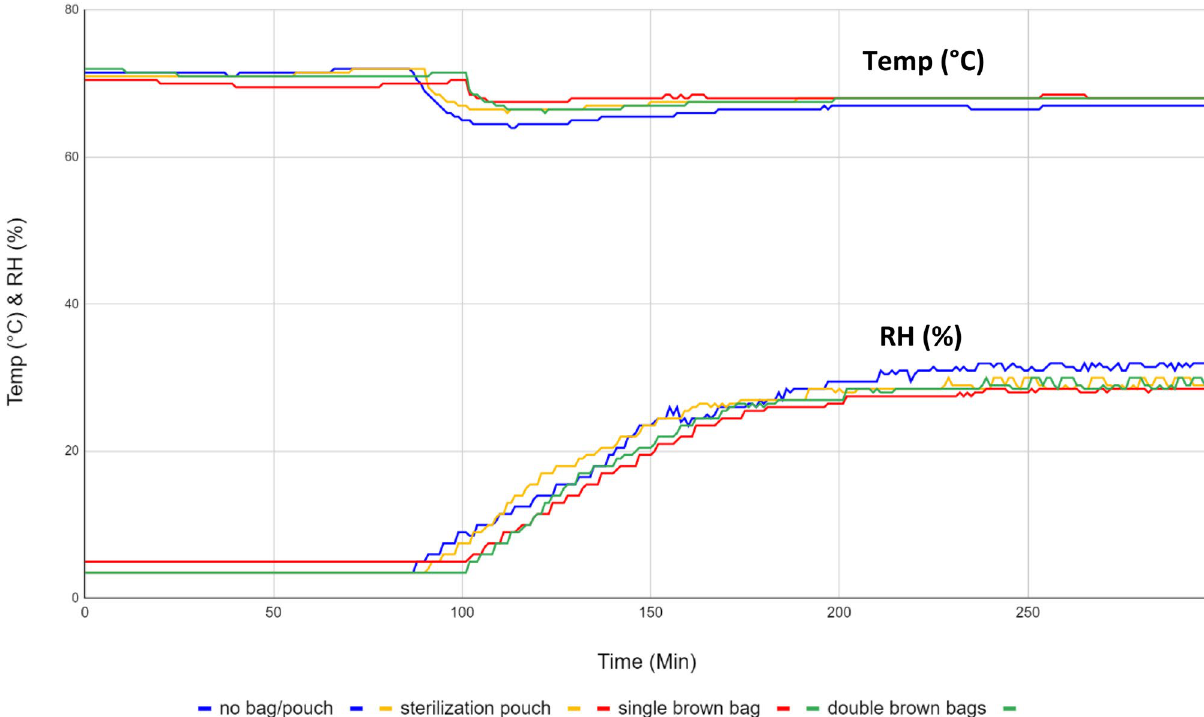
Figure 2. Temperature and relative humidity measured inside the warming cabinet when the temp/RH logger was placed inside a sterilization pouch, inside a single or double bags or no bag/pouch.